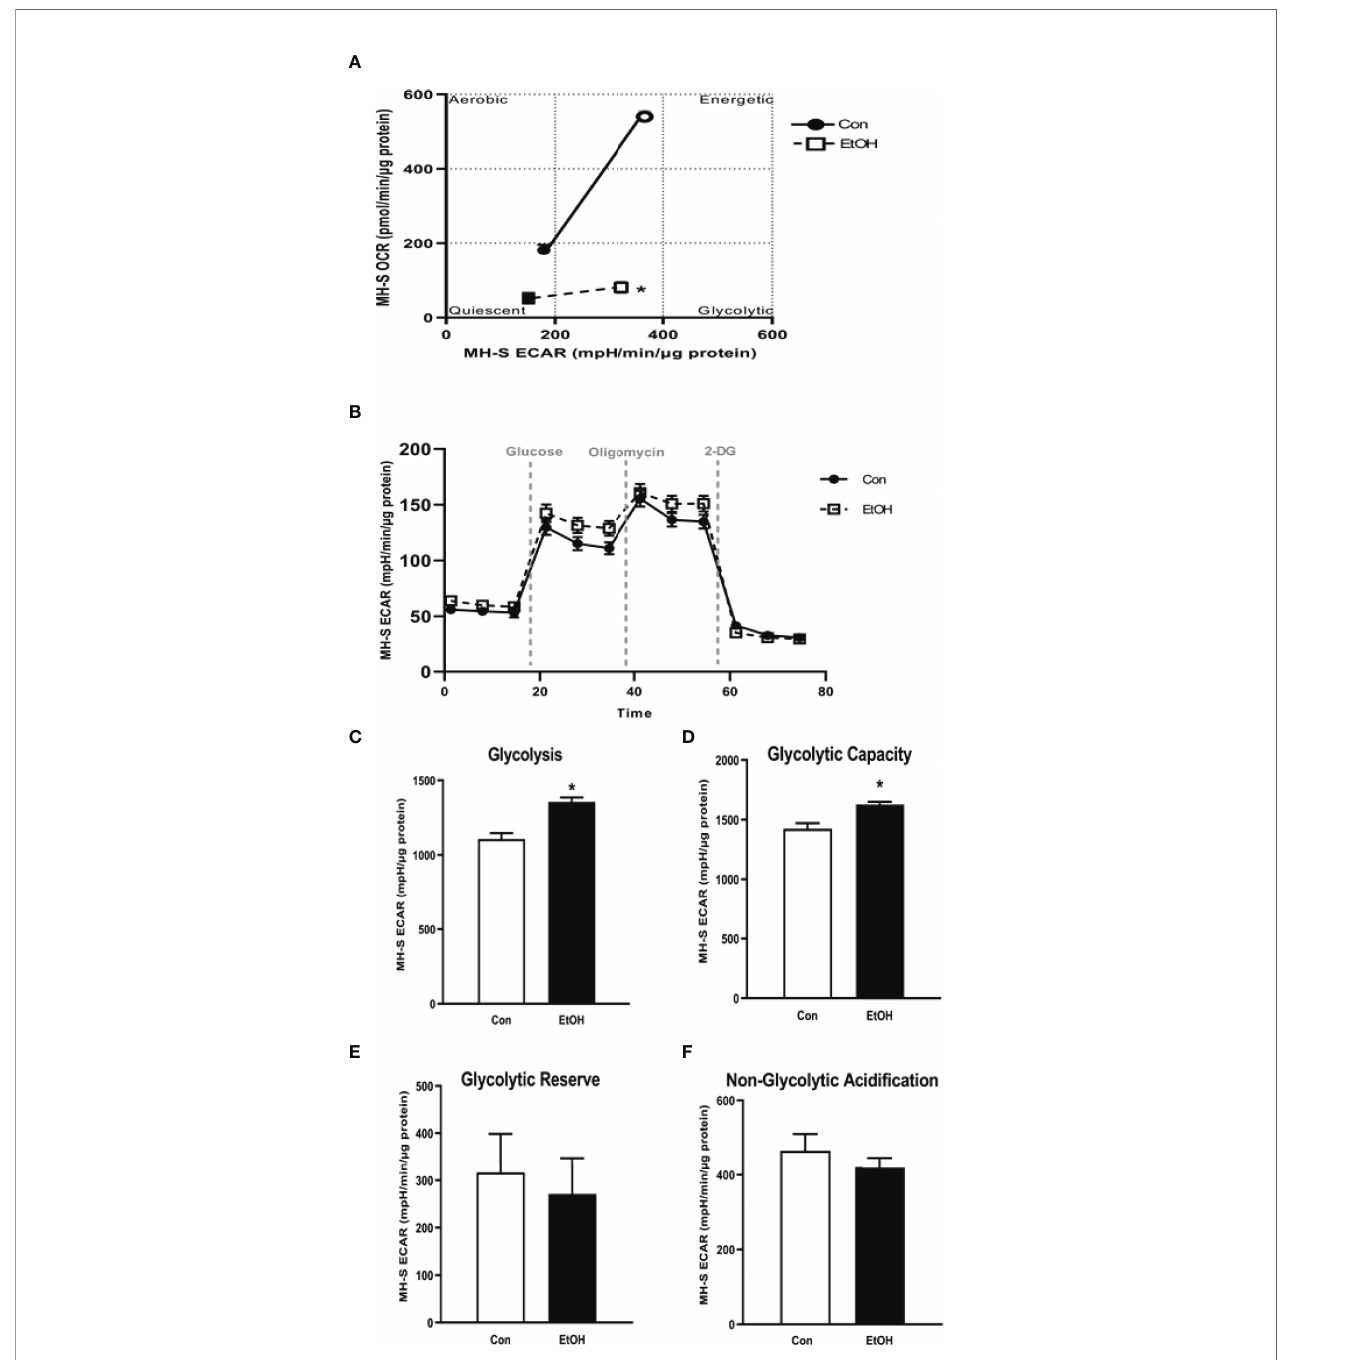
FIGURE 2 | EtOH induces glycolysis in MH-S cells. MH-S were exposed to either control (Con) or ethanol (EtOH; 0.08%) for 72 hours. (A) Oxygen consumption rates (OCR) and extracellular acidi fi cation rates (ECAR) were measured in response to an injection mixture of oligomycin (oligo; mitochondrial complex V inhibitor), carbonilcyanide p-tri fl ouromethoxyphenylhydrazone (FCCP; ATP synthase inhibitor and proton uncoupler) using an extracellular fl ux analyzer. Cell energy phenotype was measured, normalized to protein levels, and are expressed as mean ± SEM (n = 3). ECAR were measured in response to sequential injections of glucose (saturating concentration of glucose to promote glycolysis), oligomycin (ATP synthase inhibitor), and 2-deoxy-glucose (2-DG; a glucose analog that inhibits glycolysis) using an extracellular fl ux analyzer. OCR measures are pmol over time and ECAR measures are mpH over time, normalized to total protein in the same sample well, and are expressed as mean ± SEM. Parameters of glycolytic function (B) , glycolysis (C) , glycolytic capacity (D) , glycolytic reserve (E) , and non-glycolytic acidi fi cation (F) are expressed as mean ± SEM, relative to control (n = 6). * p < 0.05 verses